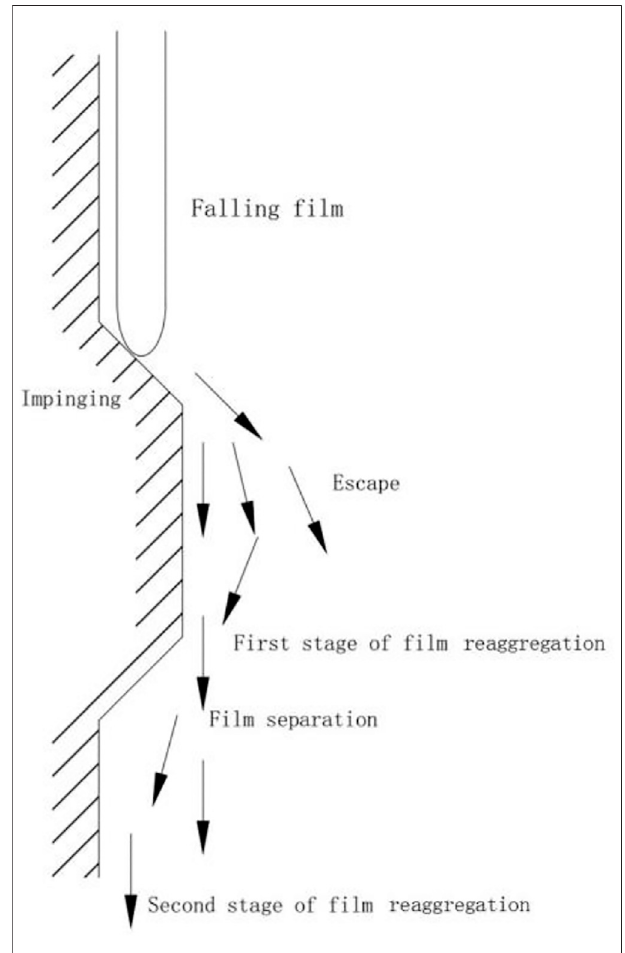
FIGURE 7 | Schematic of fi lm impinging on the attached